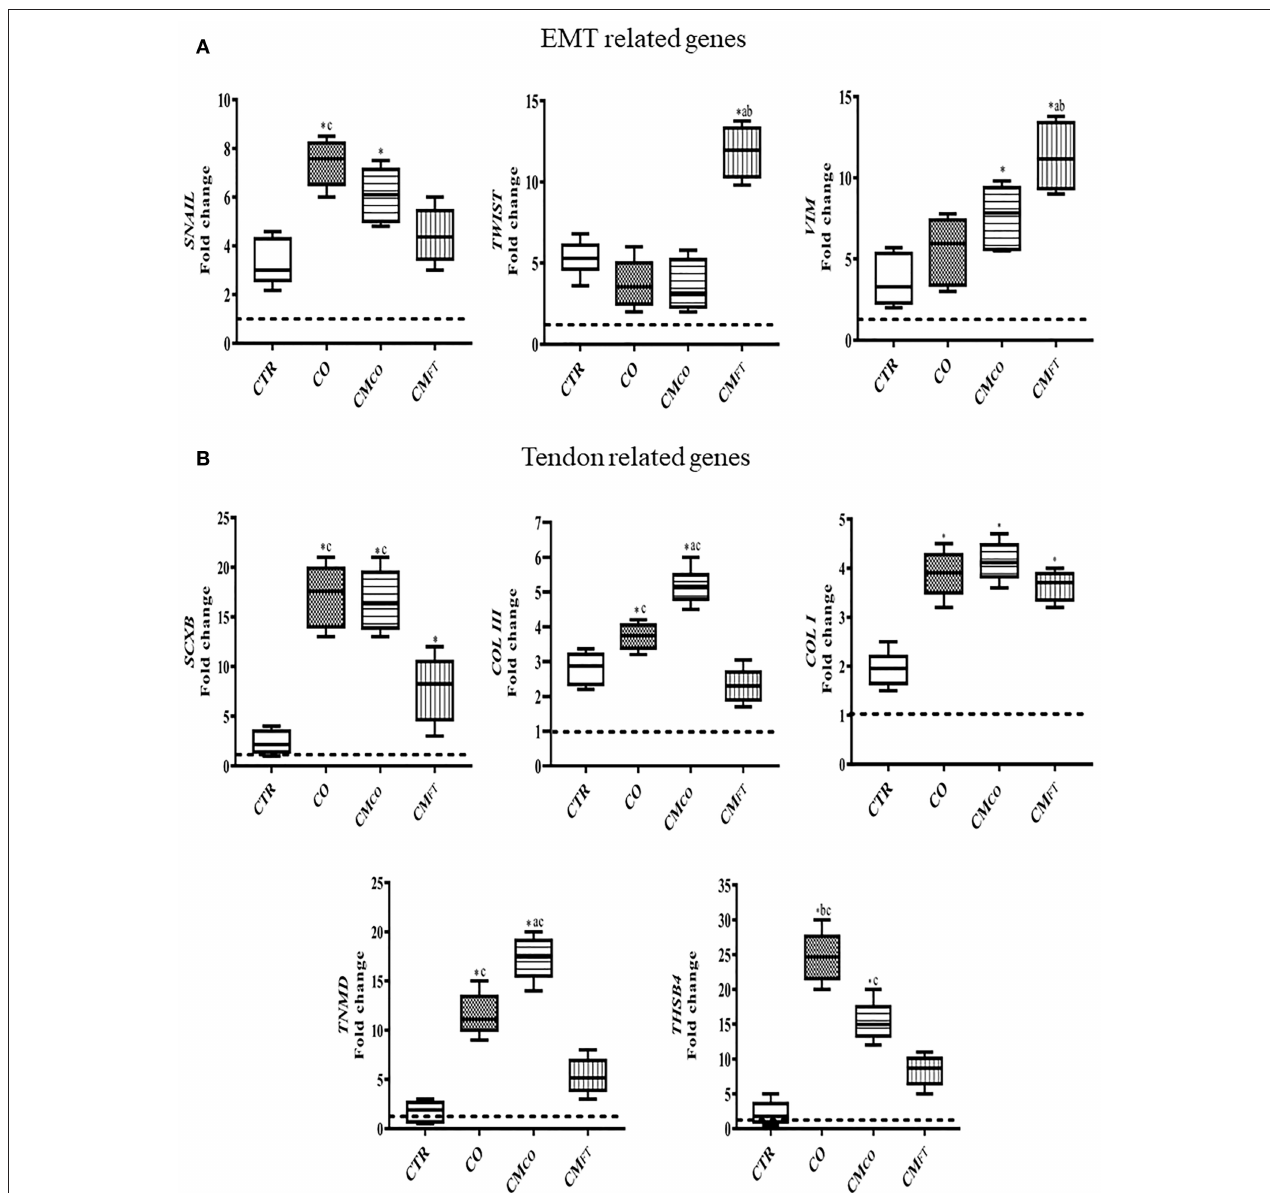
FIGURE 3 | CM CO promotes upregulation of tendon-linked gene expression. Gene expression profile by Real time qPCR analysis of (A) EMT genes and (B) tendon related genes in AECs cells cultured for 14 days in different experimental conditions. Relative quantification of each mRNA gene expression normalized to endogenous GAPDH (internal control) was calculated using the 11 Ct method and expressed as fold change over the AECs T0 = 1 (calibrator; dashed line). Values were considered significant for p < 0.05, with the indicated superscripts *vs. CTR, a vs. CO, b vs. CM CO, c vs. CM FT , respectively.